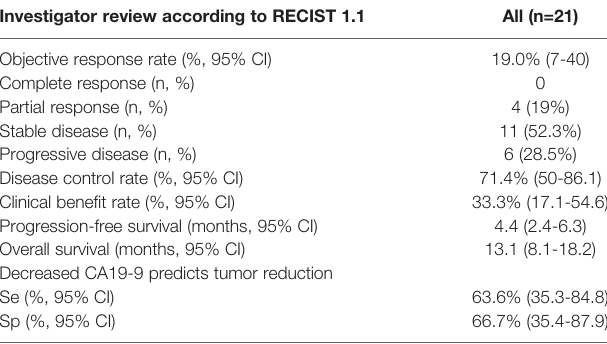
TABLE 2 | Clinical ef fi cacy in BTC patients treated with apatinib plus camrelizumab. Investigator review according to RECIST 1.1